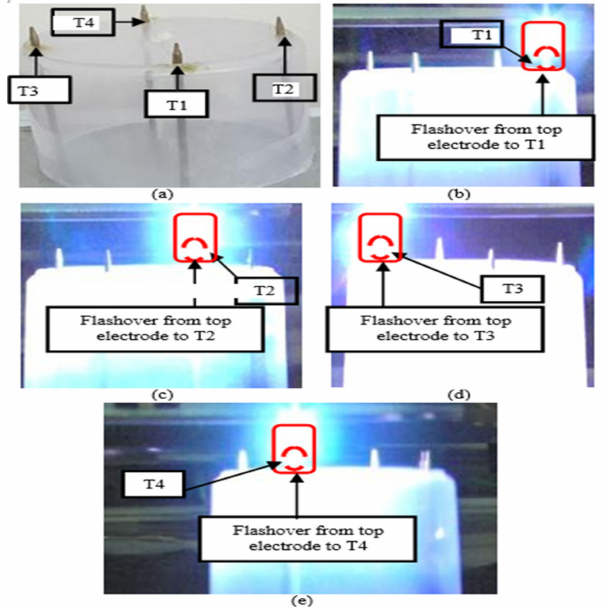
Figure 13. Lightning strike distribution on a cylindrical model: ( a ) scaled cylindrical shape, ( b ) strike on LAT1, ( c ) strike on LAT2, ( d ) strike on LAT3, ( e ) strike on